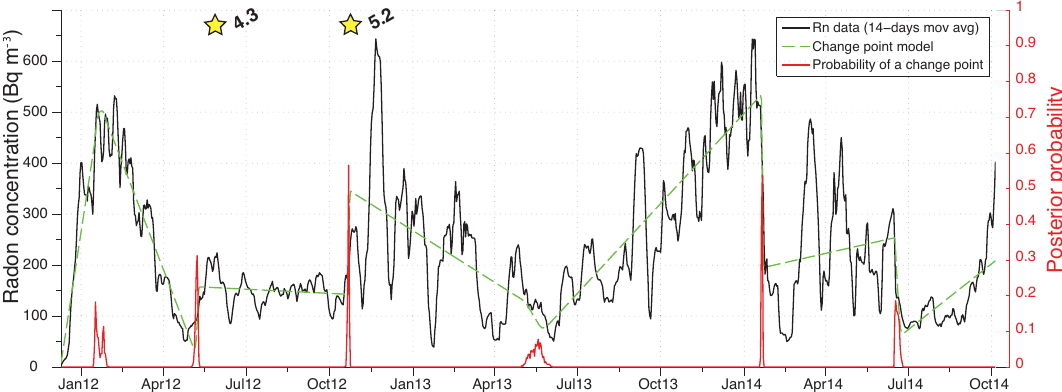
Figure 8. Change point analysis applied to time series of radon concentration at MMN. The black solid line represents the radon concen- tration at MMN filtered with a 14-day moving average, while the green dashed line represents the model predicted by the Bayesian Change Point (BCP) algorithm. The red line represents the probability of a change point at each time. Yellow stars represent the occurrence of the earthquakes Mw4.3 on 28 May 2012 and Mw5.2 on 25 October 2012.